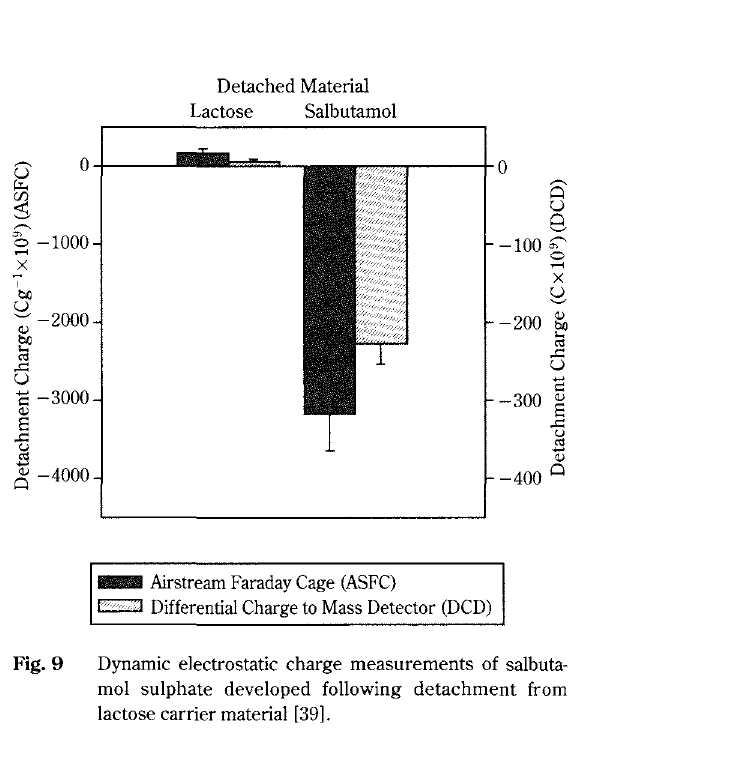
Dynamic electrostatic charge measurements of salbuta· mol sulphate developed following detachment from lactose carrier material [39].